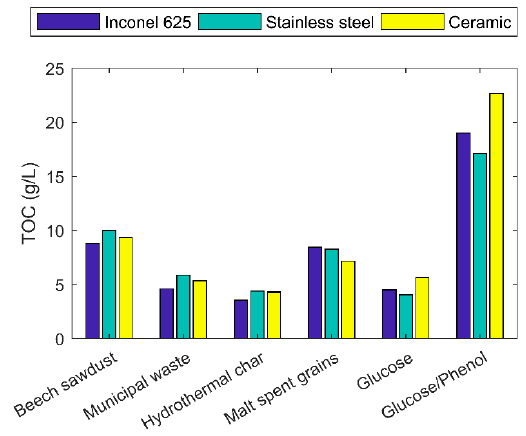
Figure 4. Total organic carbon (TOC) of the liquid phase from the SCWG of the considered samples.